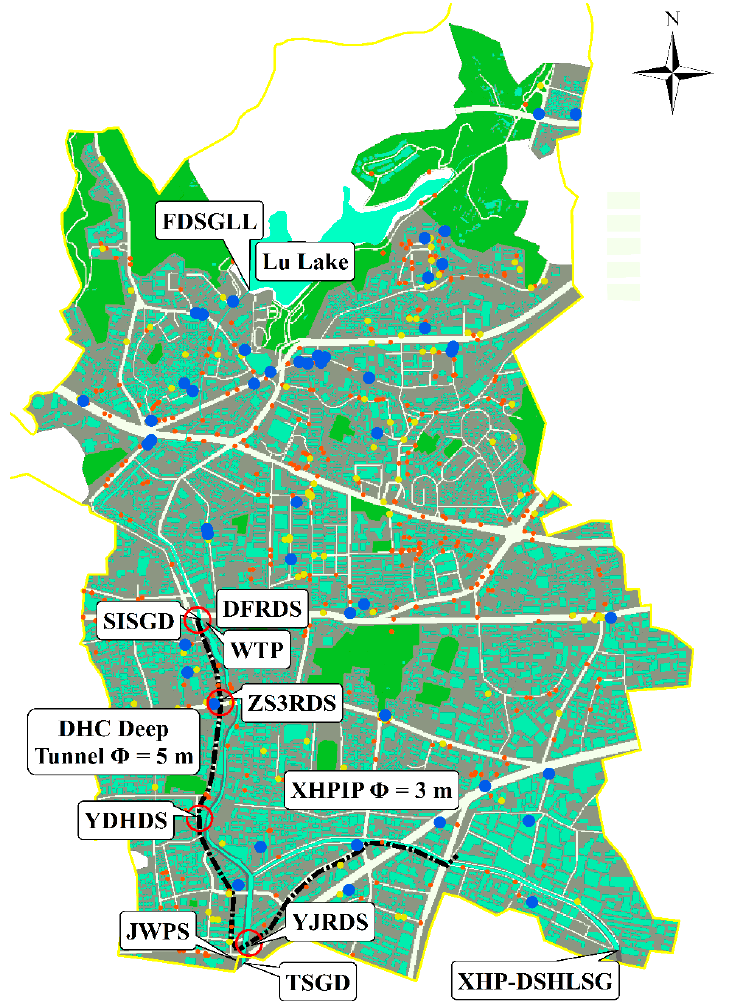
Figure 1. Basic survey map of the DongHaoChong basin.